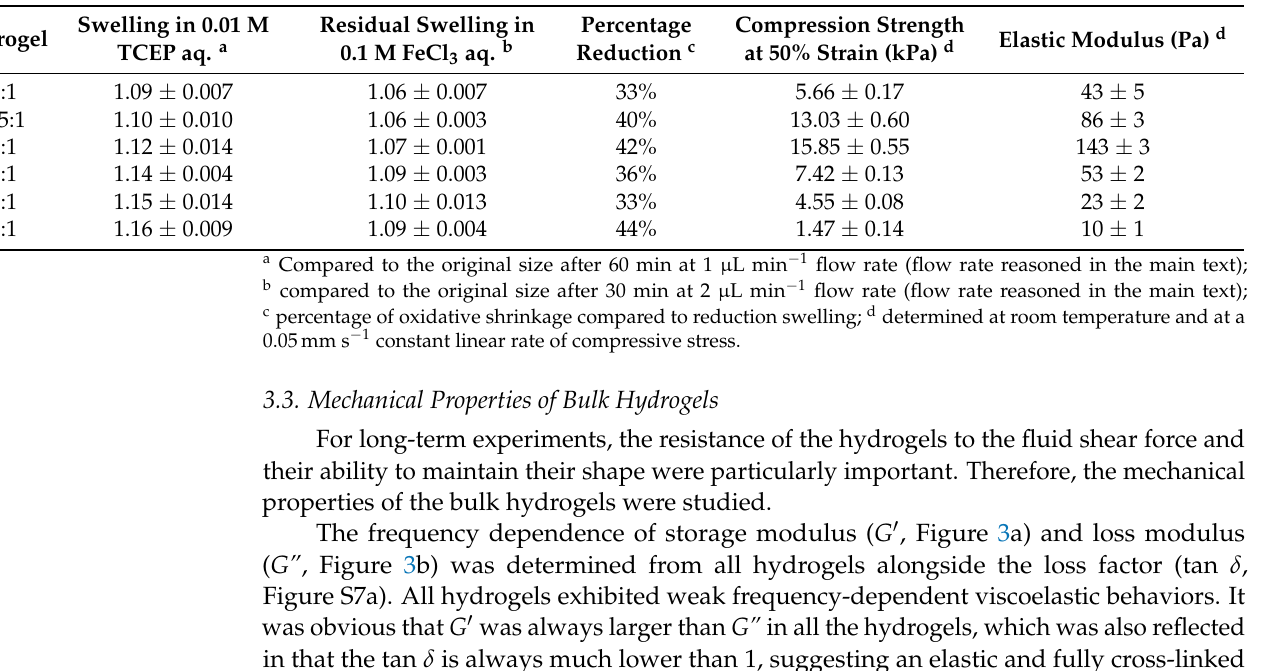
Table 1. Swelling behaviors and mechanical properties of PNiPAAm hydrogel dots in microfluidics.